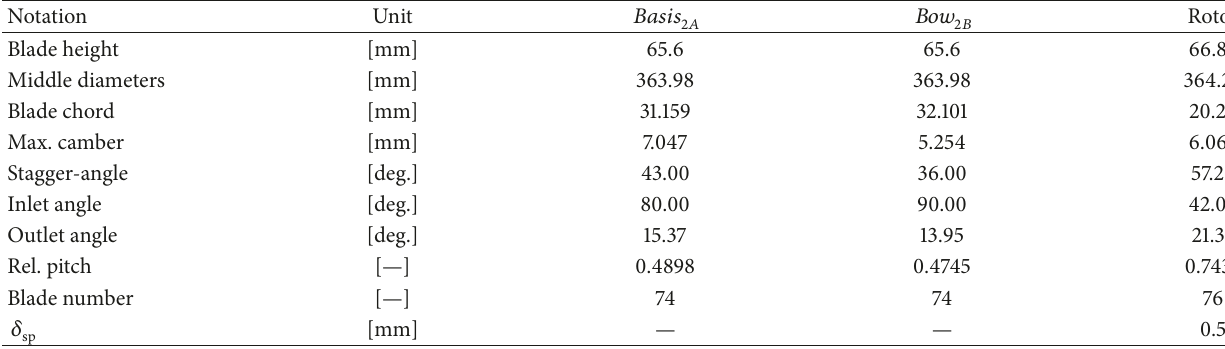
Table 1: Geometrical data of the center line profiles.